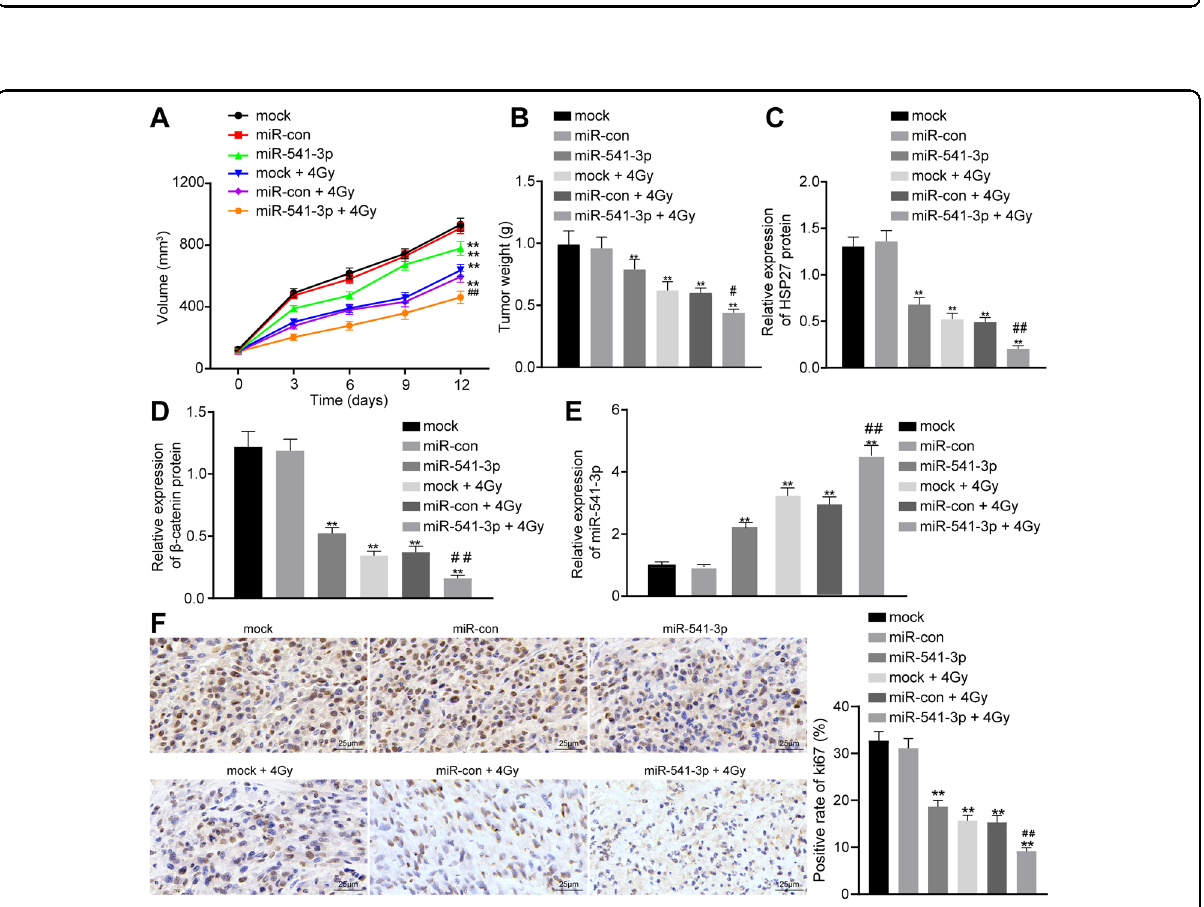
Fig. 5 miR-541-3p enhances radiosensitivity of PCa cells in xenograft tumor model. LNCaP cells with and without miR-NC and miR-541-3p transfection were subcutaneously injected into the nude mice. Fourteen days after injection, the xenograft sites were exposed to a single dose of 4 Gy X-ray radiation using Faxition 43885D X-ray machine. The tumor size was measured every 2 days using a caliper. The xenograft tumor was dissected 12 days after radiation, weighed, and lysed for western blot assay. A Tumor size measured with caliper. B The weight of xenograft tumors. C HSP27 protein expression in tumor tissues measured by western blot assay. D The expression level of β -catenin protein in tumor tissues measured by western blot assay. E The expression level of miR-541-3p in tumor tissues determined by RT-qPCR. F The Ki67 expression rate in tumor tissues of nude mice detected by immunohistochemistry. ** p < 0.01 relative to mock + 0 Gy radiation, # p < 0.05 relative to mock + 4 Gy radiation, and ## p < 0.01 relative the mock + 4 Gy radiation; one-way analysis of variance was used for comparison between groups and repeated-measurement analysis of variance was used for tumor volume at different time points, with the values represented as mean ± SEM ( n = 5).